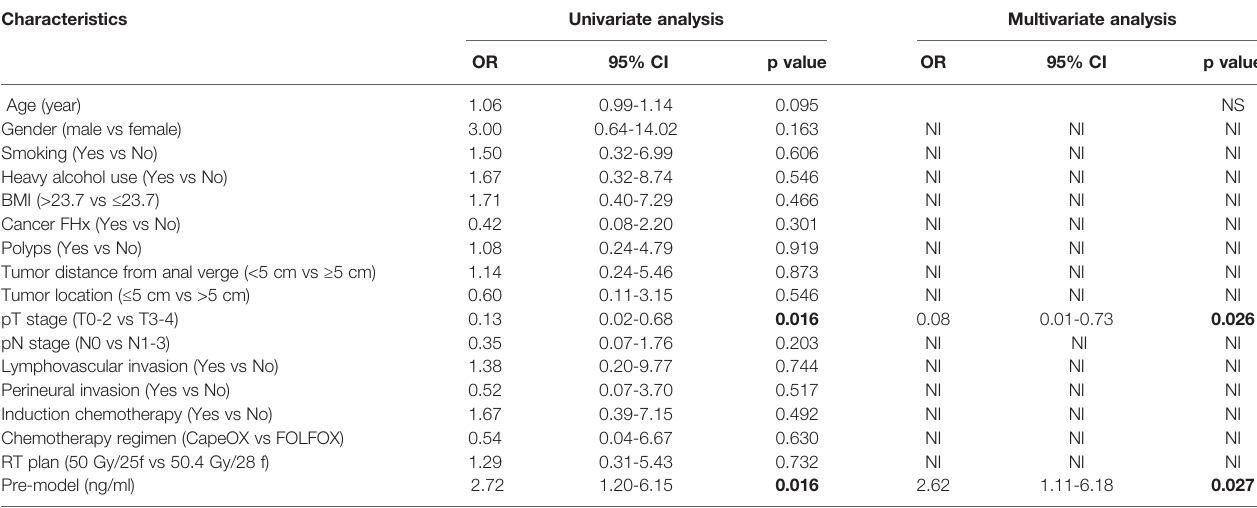
TABLE 2 | Univariate and multivariate analyses of factors associated with treatment response.